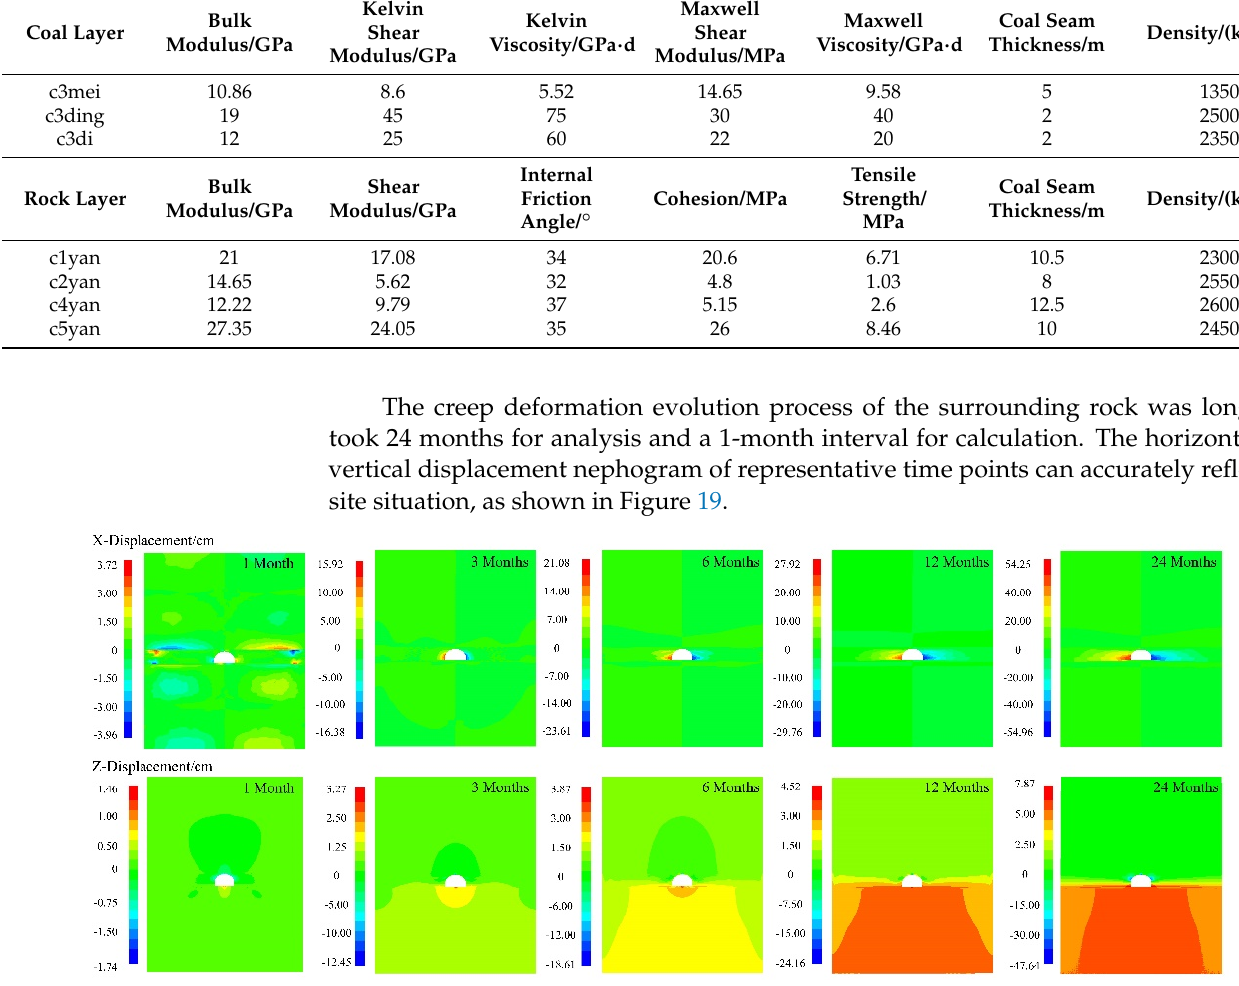
Figure 19. Displacement nephogram of roadway during 24 months of creep. From the X-displacement nephogram, it can be seen that the maximum displacement occurred at the arch shoulder of the roadway. The horizontal convergence displacement at 1, 3, 6, 12, and 24 months was 3.96, 16.38, 23.61, 29.76, and 54.96 cm, respectively. In the same time interval, the D-values were 12.42, 7.23, 6.15, and 25.2 cm, respectively. From the Z-displacement nephogram, the settlement of the arch crown and the bulge of the arch bottom existed during the creep period. The maximum displacement occurred at the top of the arch. At 1, 3, 6, 12, and 24 months, the maximum deformation values of the roadway arch crown subsidence were 1.74, 12.45, 18.61, 24.16, and 47.64 cm, respectively. At the same interval in the first year, the D-values were 10.71, 6.16 cm, 5.55 cm, and 23.48 cm, respectively. In conclusion, at the initial stage of creep, the deformation rate of surrounding rock changed from fast to slow and gradually became stable, and the deformation of the sur- rounding rock gradually converged. However, due to long-term creep, the coal and rock properties gradually changed from elastic to plastic. If the support is not strengthened in time, the plastic surrounding rock cannot be restored to its original state, and the deforma- tion will continue to increase, which will lead to roadway instability. Finally, it will lead to the occurrence of geological environment disasters such as surface